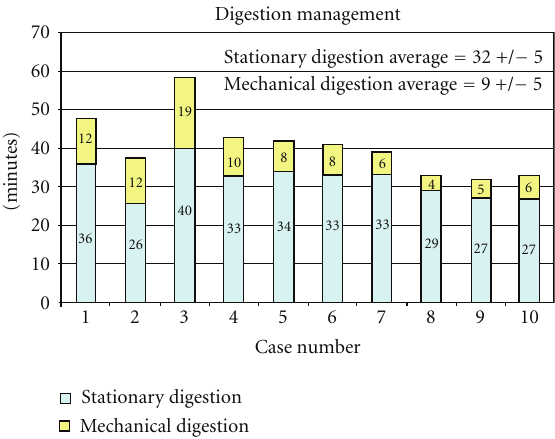
Figure 5: The pancreatic organ of young patients is subjected first to a stationary digestion characterized by prolonged infusion of prewarmed collagenase-neutral protease solution. Mechanical shaking is carried out after stationary digestion and limited in time to avoid excessive breakage of islets embedded in exocrine